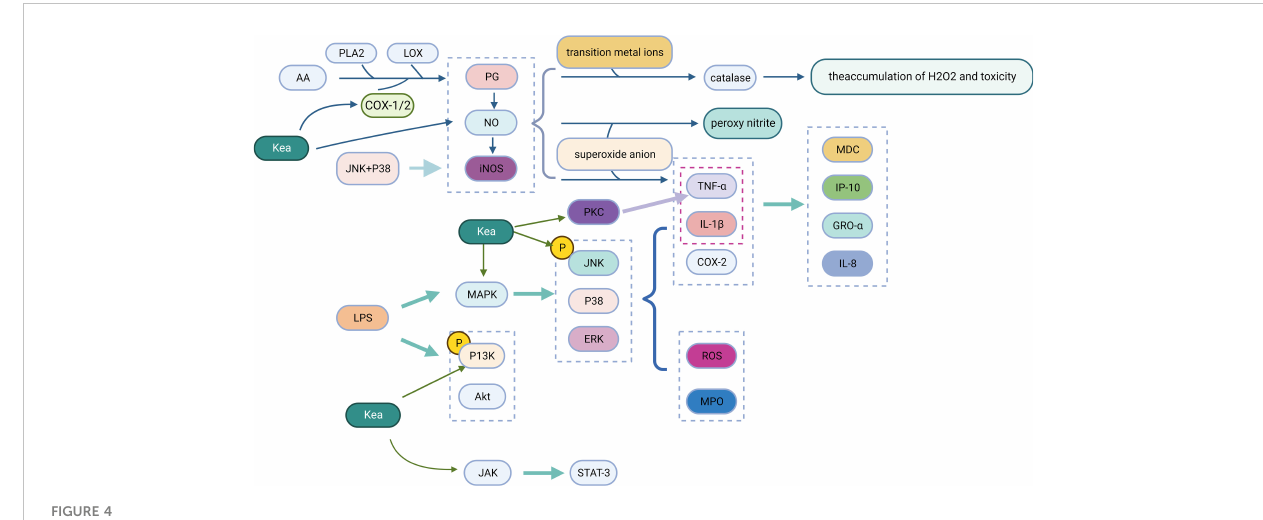
FIGURE 4 Anti-in fl ammatory mechanism of Kea (Created with